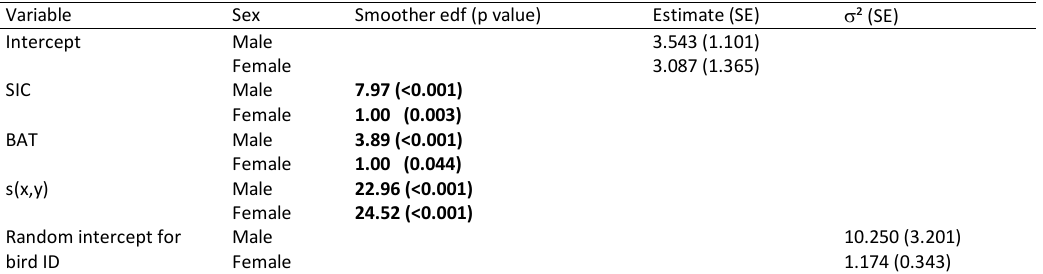
Table 4. Generalized Additive Mixed Model (GAMM) results for foraging probability of male and female snow petrels as a function of sea ice concentration (SIC), bathymetry (BAT) and spatial autocorrelation (s(x,y)). edf indicates the estimated degrees of